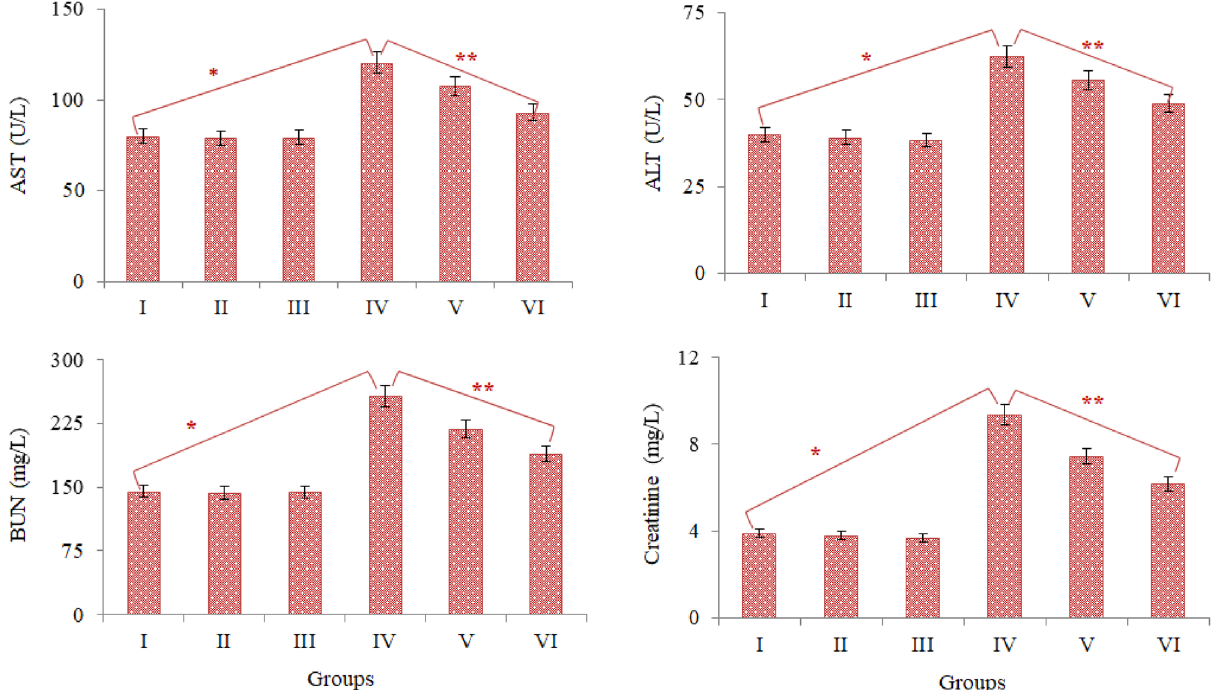
Figure 3. The effect of AFM 1 and t-rsv on serum parameters. Group I: Control, Group II: 10 mg/kg b.w. t-rsv, Group III: 20 mg/kg b.w. t-rsv, Group IV: 16 mg/kg b.w. AFM 1 , Group V: 10 mg/kg b.w. t-rsv + 16 mg/kg b.w. AFM 1 , Group VI: 20 mg/kg b.w. t-rsv + 16 mg/kg b.w. AFM 1. Values are shown as mean ± SD (n = 6).*indicates the statistical difference between Groups I and IV, **indicates statistical difference between Groups IV and VI (p <